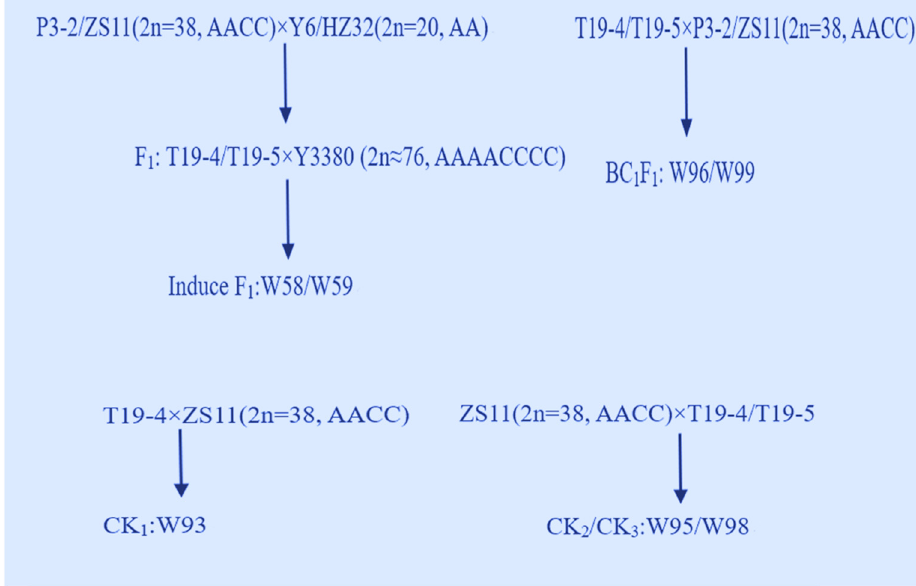
Figure 6. Schematic diagram of each hybrid combination.